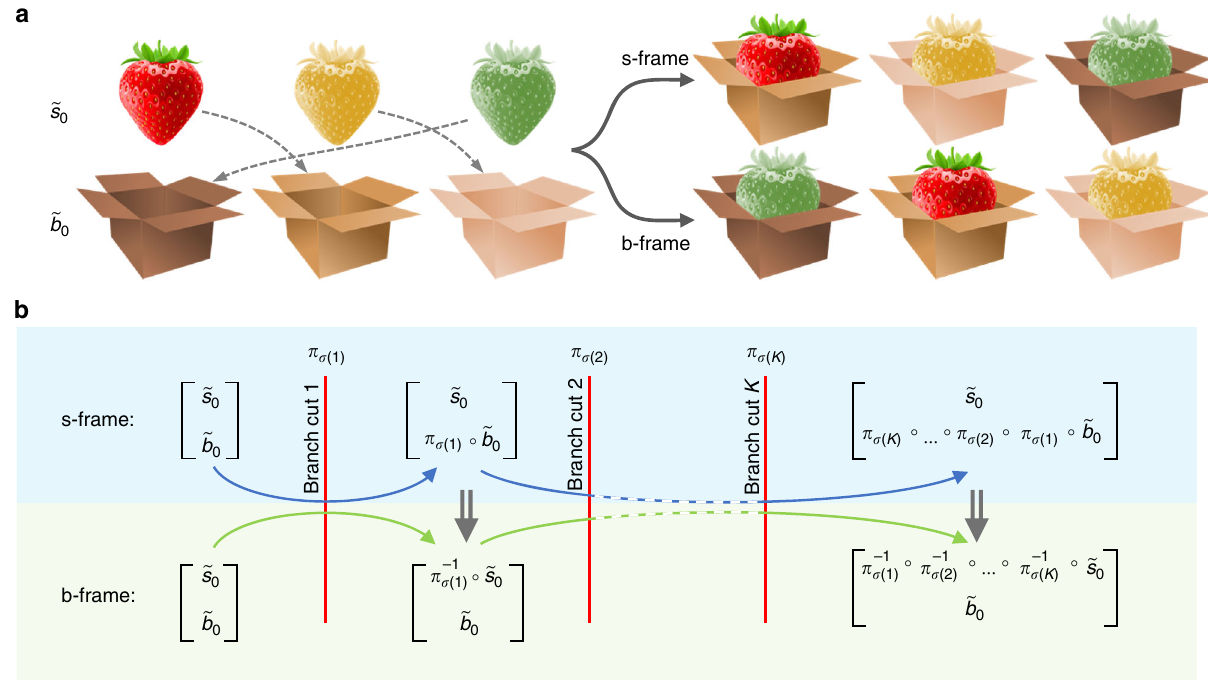
Fig. 2 Different permutation frames. a A simple illustration of the two different frames used for representing the same con fi guration. b A summary of the mathematical formulation of the concept depicted in a (see main text for more